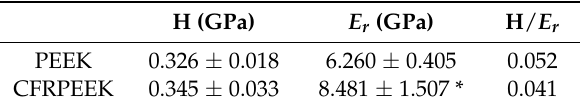
Figure 1. Typical nanoindentation curves of PEEK and CFRPEEK at a peak load of 3 mN with a Berkovich indenter. Table 2. Values of nanohardness (H), reduced elastic modulus ( E r ) and their ratio (H/ E r , H 3 / E 2 r ) obtained in the nanoindentation tests. * p < 0.05, statistically significant difference; PEEK versus CFRPEEK.